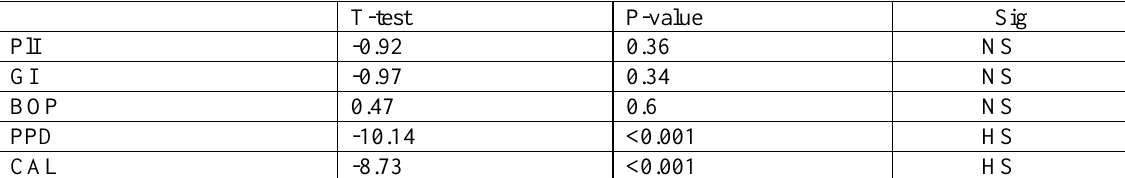
Table 2: Intergroup comparison for the periodontal parameters with significant differences